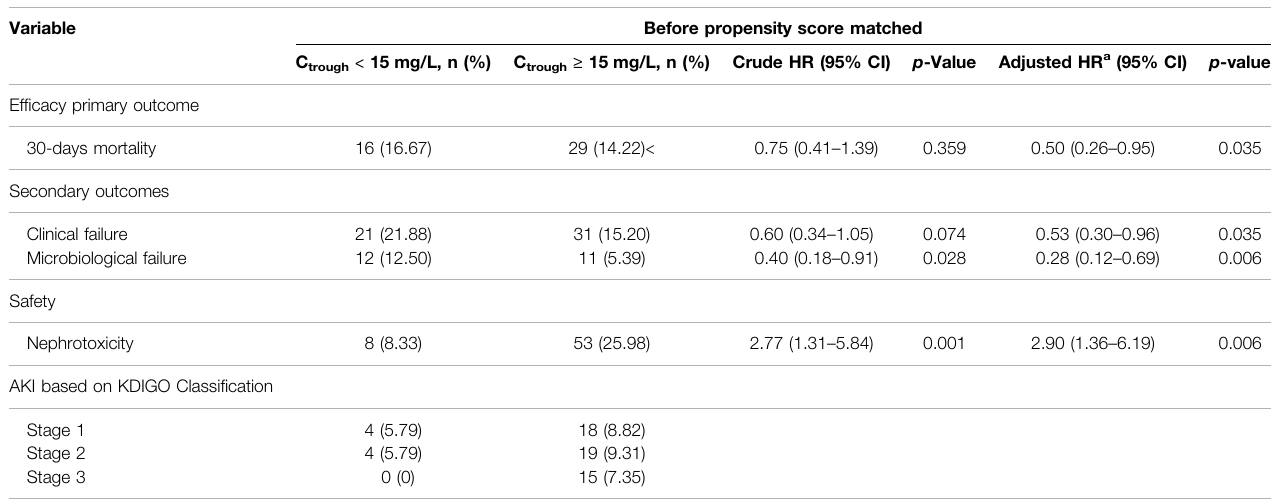
TABLE 2 | Cox regression analysis of primary and secondary outcomes for enterococcal infection patients with vancomycin trough concentration ≥ 15 mg/L. Variable Before propensity score